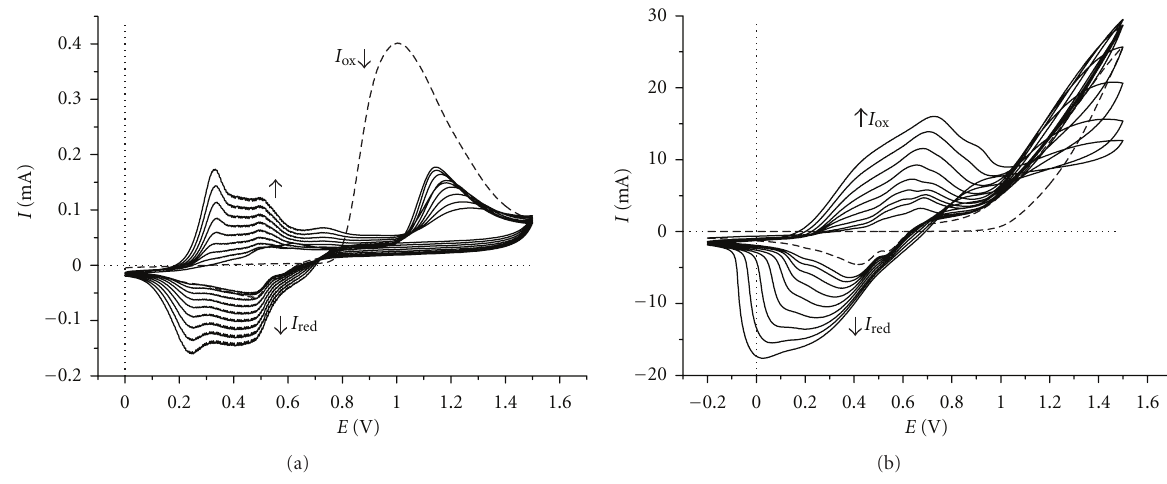
Figure 7: Multicyclic voltammograms (20 cycles) of AnPS-aniline mixture (10 − 2 M) in H 2 SO 4 (1M) aqueous solution at (a) Pt plate (1 × 0.5cm 2 ) and (b) ITO glass (2.5 × 2.5 cm 2 ) working electrode; the dotted line represents the first cycle. Scan rate: 50 mVs − 1 .